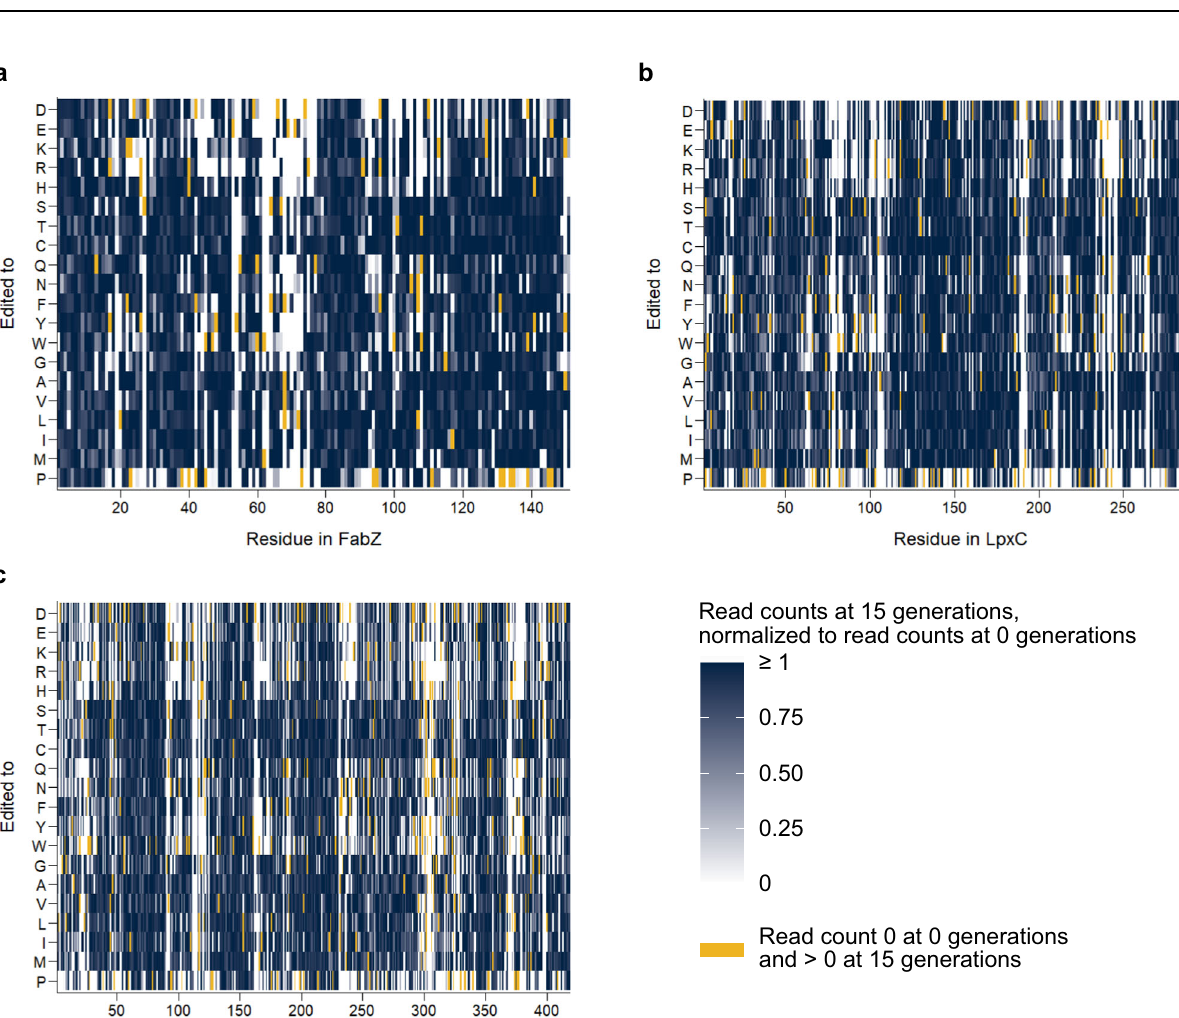
Fig. 3 | Saturation editing libraries reveal a surprisingly high tolerance for amino acid substitutions in three essential E. coli proteins. Bar plots show the numberofsuccessfulaminoacidchangesateachpositionoftheproteinsFabZ( a ), LpxC ( b ) and MurA ( c ). Successful amino acid changes were de fi ned as edits that werefoundtobepresentinthelibraryafter15generationsofgrowth(averageread count >0). d The cumulative frequency distribution of successful amino acid